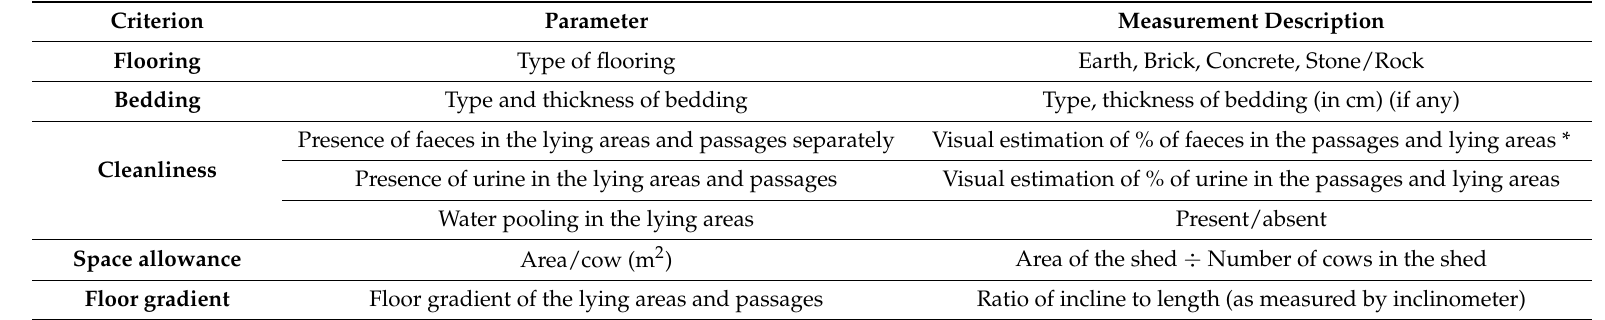
Table 1. Shelter housing parameters for assessment of floor characteristics.